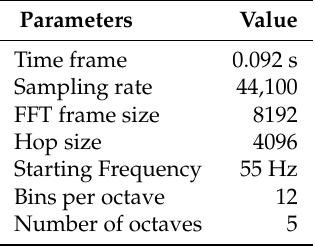
Table 1. Preprocessing Parameters.